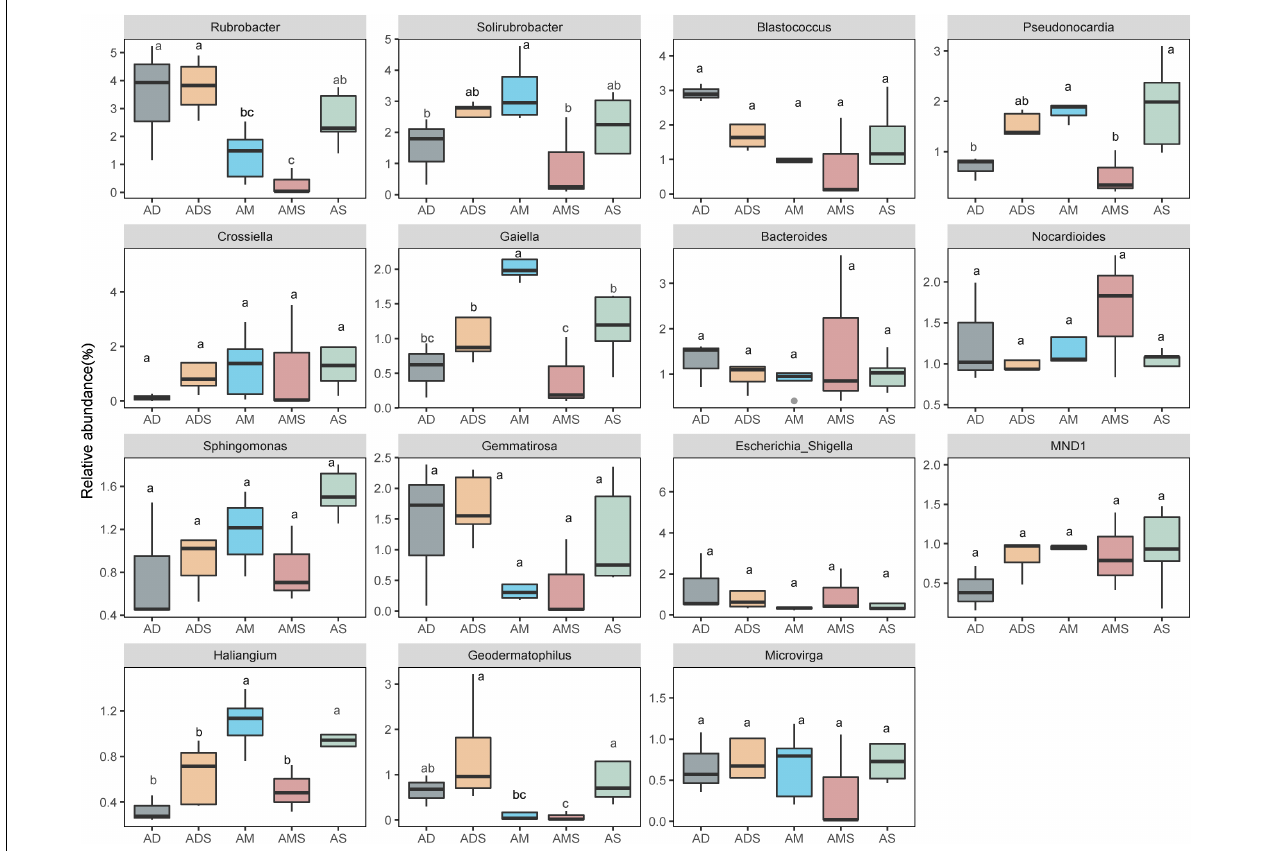
FIGURE 3 | Differences in soil bacteria among alpine grasslands at the genus level on the Tibetan Plateau. AD, alpine desert; ADS, alpine desert steppe; AM, alpine meadow; AMS, alpine meadow steppe; AS, alpine steppe. Different lowercase letters marking the same genus represent significant differences between two alpine grasslands ( P <